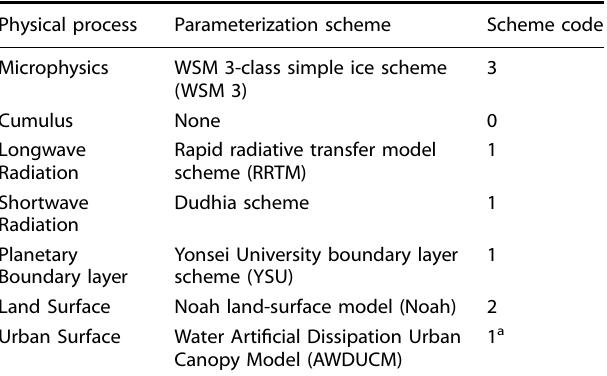
Table 2. Parameterization schemes and codes used by WRF to simulate different physical